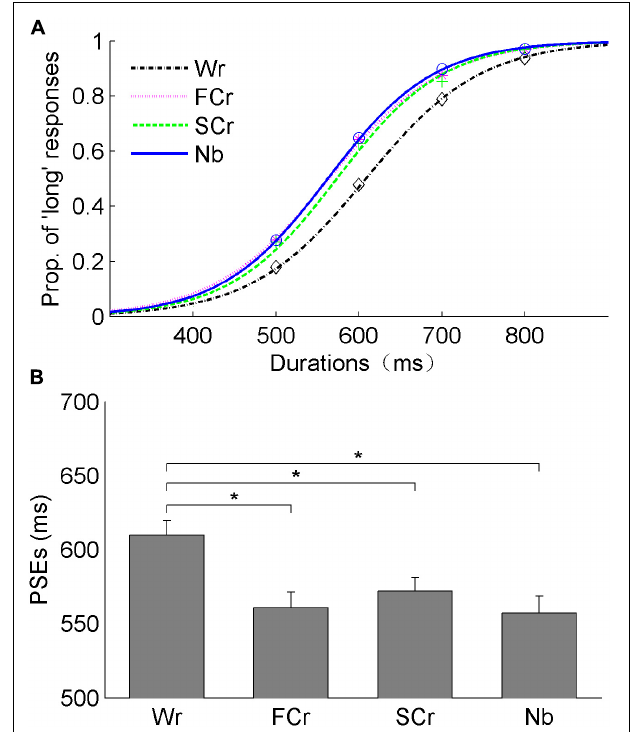
FIGURE 3 | Results of Experiment 2a. (A) The fitted curves show the mean proportions of “long” responses against the comparison durations in the conditions of Wr, FCr, SCr, and Nb. (B) The bars show the mean points of subjective equality (PSEs) and their corresponding standard errors for the four experimental conditions (all * p <